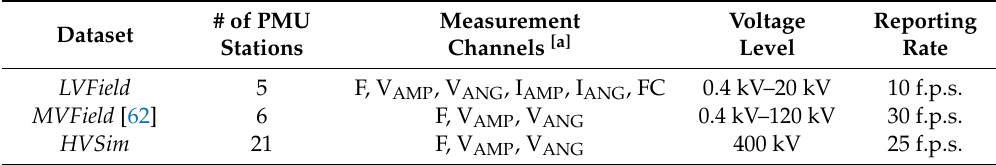
Table 5. Overview of used datasets within this